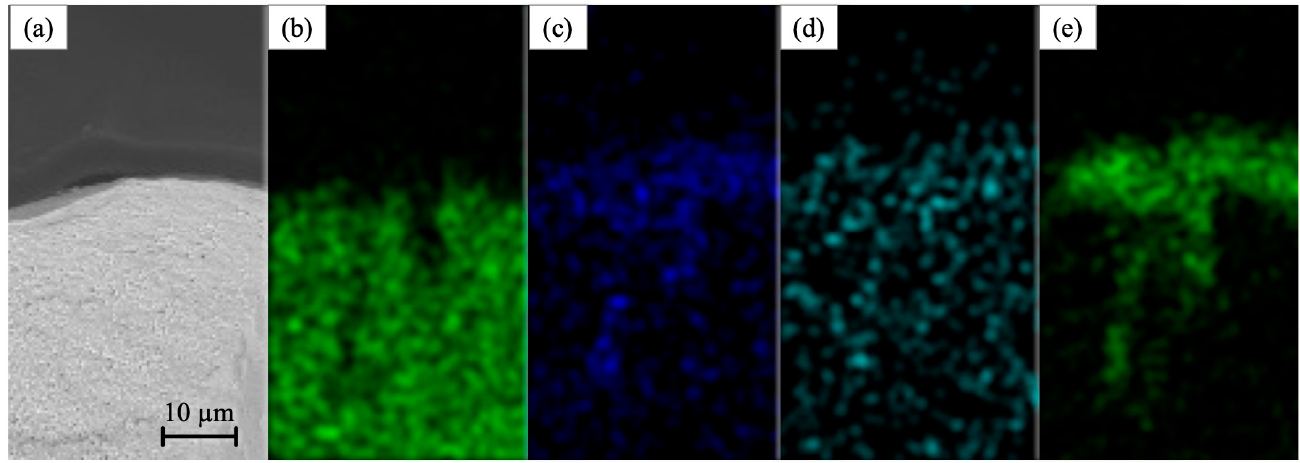
Figure 2. The composite wire images obtained by scanning electron microscopy ( a ) and X-ray fluorescence at wavelengths corresponding to Cu-K α ( b ), Fe-K α ( с ), Co-K α ( d ), and Ni-K α ( e ).